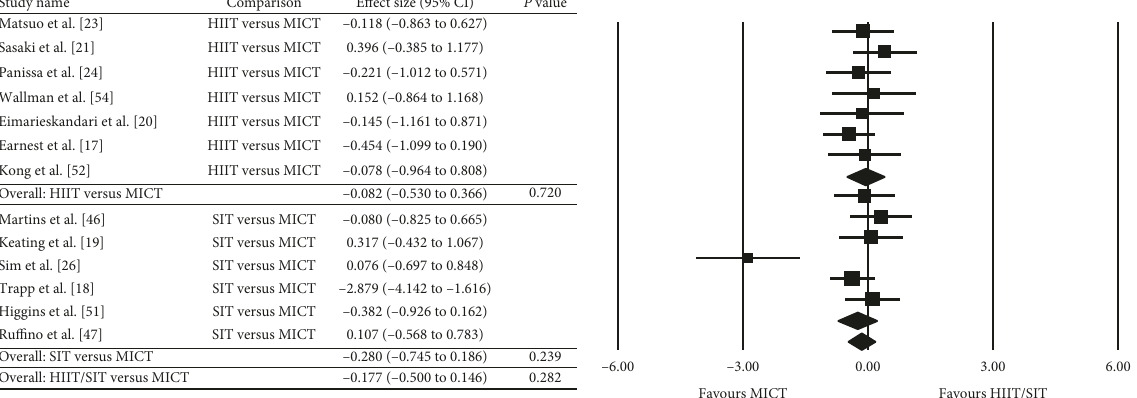
Figure 2: Meta-analysis for the comparison of HIIT/SIT versus MICTon energy intake. HIIT: high-intensity interval training, SIT: sprint interval training, MICT: moderate-intensity continuous training, and CI: confidence interval.